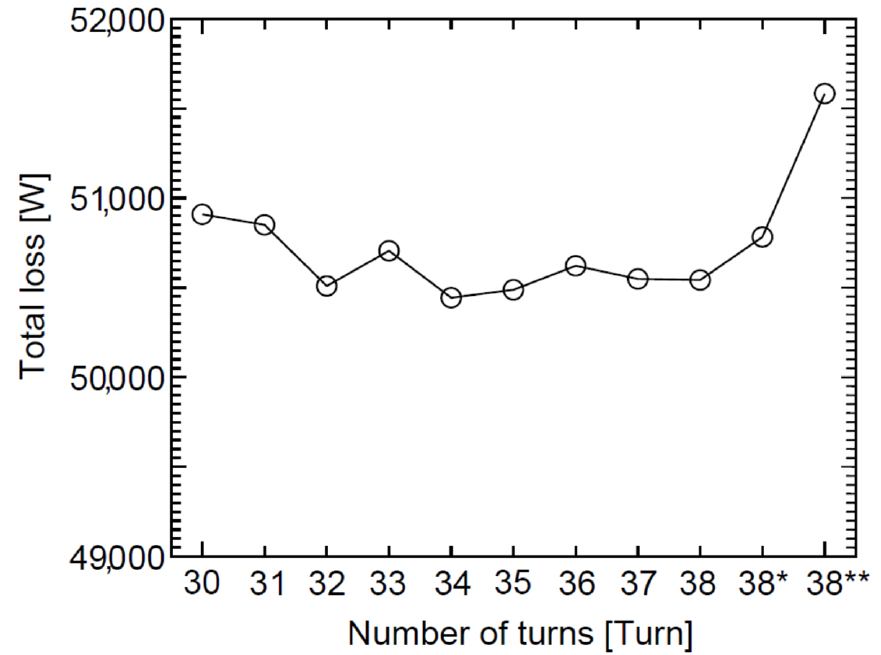
Figure 6. The lead wire loss when the secondary winding changes.